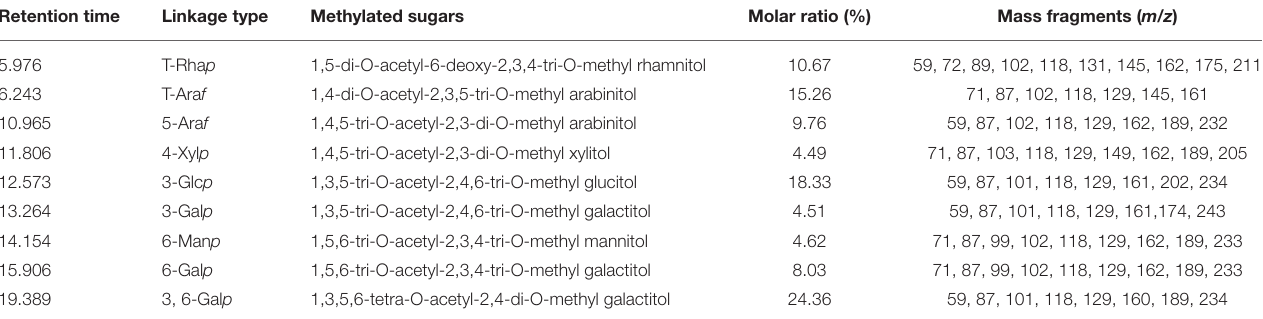
TABLE 1 | Methylation analysis of CCP.